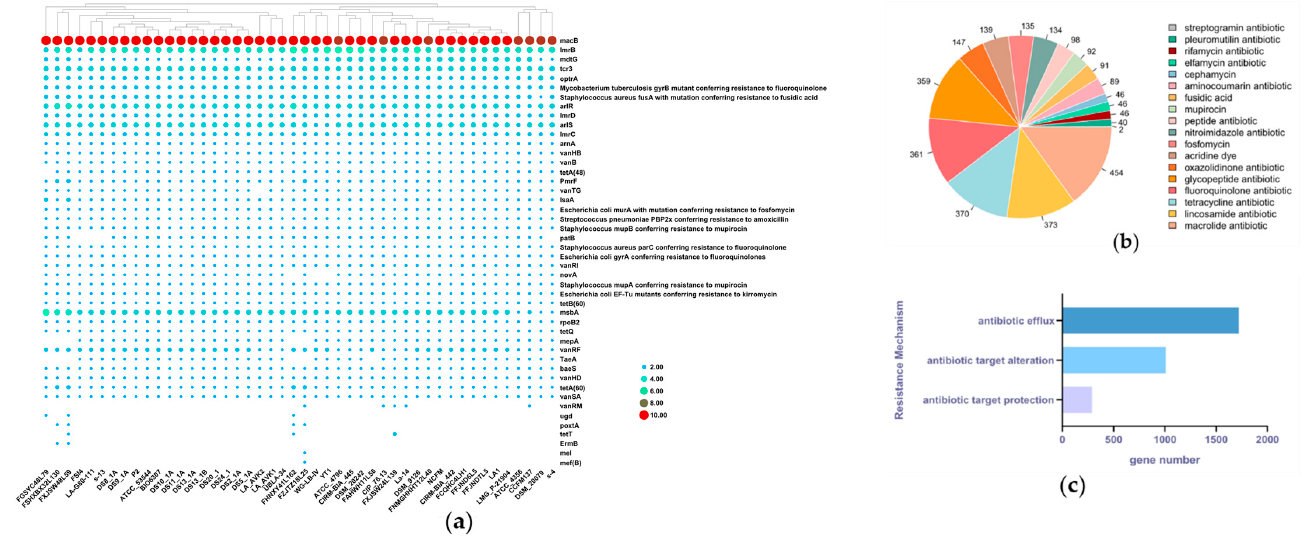
Figure 7. Antibiotic resistance gene of L. acidophilus. ( a ) Heatmap showing number of antibiotic resistance gene. ( b ) Pie chart indicating the classes of antibiotics. ( c ) Bar plot showing gene number of different kinds of resistance